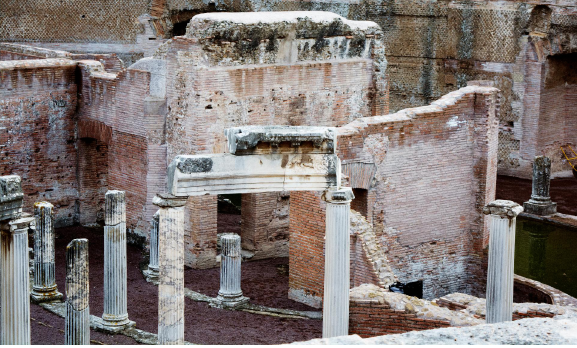
Figure 2. Picture of the reconstructed entablature with